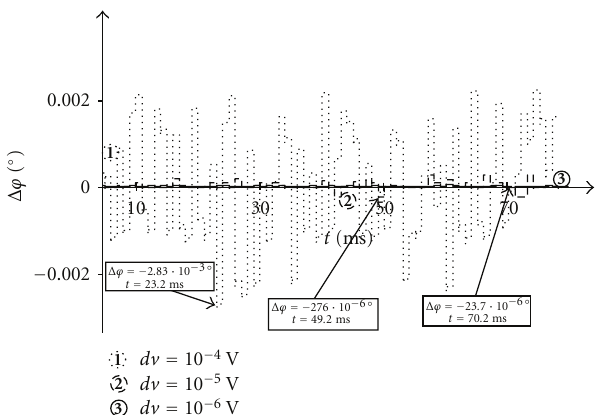
Figure 6: The phase-errors Δ ϕ between the measured and actual input-signal phase for the three di ff erent macromodel parameters dv .